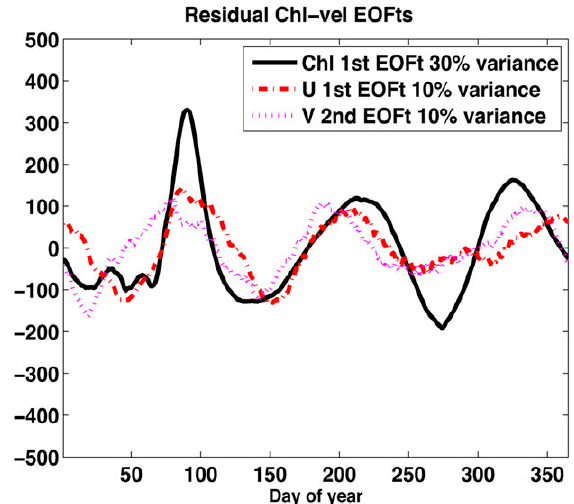
Fig. 6. – Residual first EOFts of Chl a , first EOFt of U and second EOFt of V. between the time series is significant. In Figure 7 the first EOF of residual U (Fig. 7A) and the second EOF of residual V (Fig. 7B) are shown. The first EOF of residual Chl a has already been shown in Figure 2B; note that while the zonal velocity EOF contains EAG and AOF patterns (Fig. 7A), the meridional EOF (Fig. 7B) shows an area of southward velocities (dark blue shade in the off-shore region of Malaga coast and dark blue-green in the Almeria coast and off-shore re- gion). In both off-shore zones (Malaga and Almeria) this meridional velocity component will contribute to the transport off-shore of the seasonal Chl a produced in the coastal upwelling.